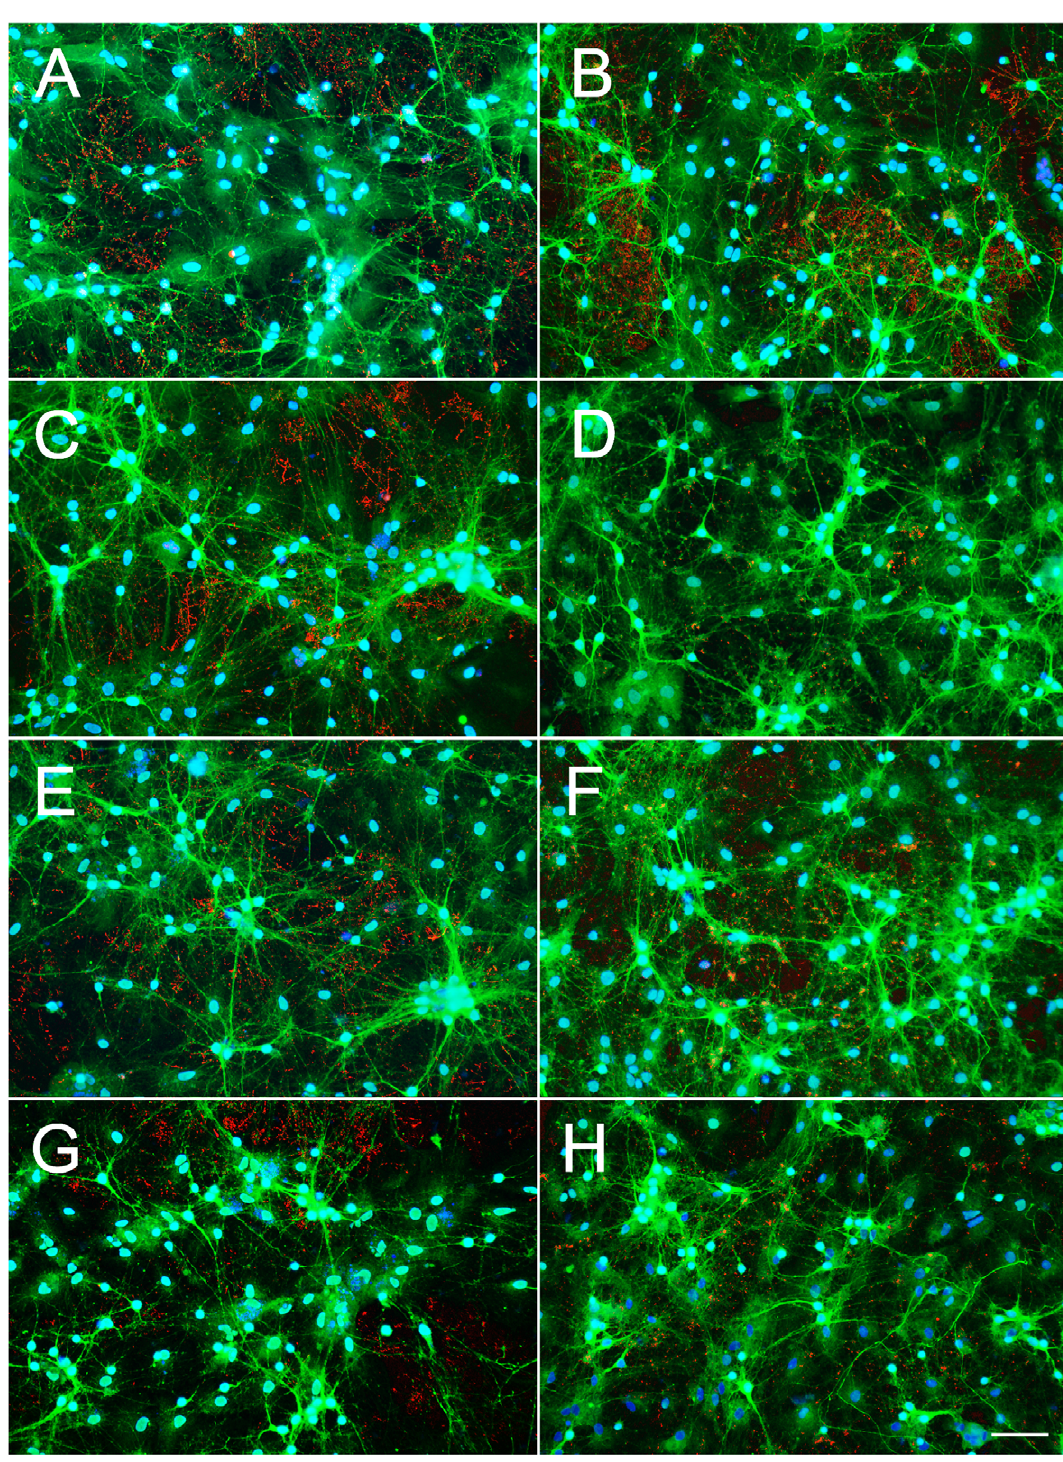
Figure 8. Effect of A b 42 treatment on Hsp40 and Hsp40 HPD-AAA -transfected neurons. Rat hippocampal neurons were transfected by electroporation with 4 m g myc-tagged Hsp40, Hsp40 HPD-AAA or vector alone and plated on silicon wafers (Silicon wafers, Silicon Quest, CA). Three days after transfection, neurons were incubated with 10 m M A b 42 (panels B,D,F,H) and 7 days post transfection hippocampal cultures were fixed with 15% Picric Acid (Sigma, P6744), 4% PFA (Sigma, P6148), blocked in donkey serum/BSA and permeabilized with 0.1% Triton-X100 (Biorad, 161-0407) for 2 hours. Cultures were immunostained with Bassoon (red) (Enzo, ADI-VAM-PS003), and Neurofilament (green) (Millipore, A1991) and DAPI (blue) (Invitrogen, D1306) and examined by microscopy via an Olympus inverted scope (BX61WI) and water submergible 10x objective (UMplanF1). The panels are as follows A,B = controls; C,D transfected with pcDNA; E,F transfected with Hsp40 and G,H transfected with Hsp40 HPD-AAA ; A,C,E,G = no A b 42 ; B,D,F,H =10 m M of A b 42 . Neurons are healthy with axon and dendritic elaboration forming networks.